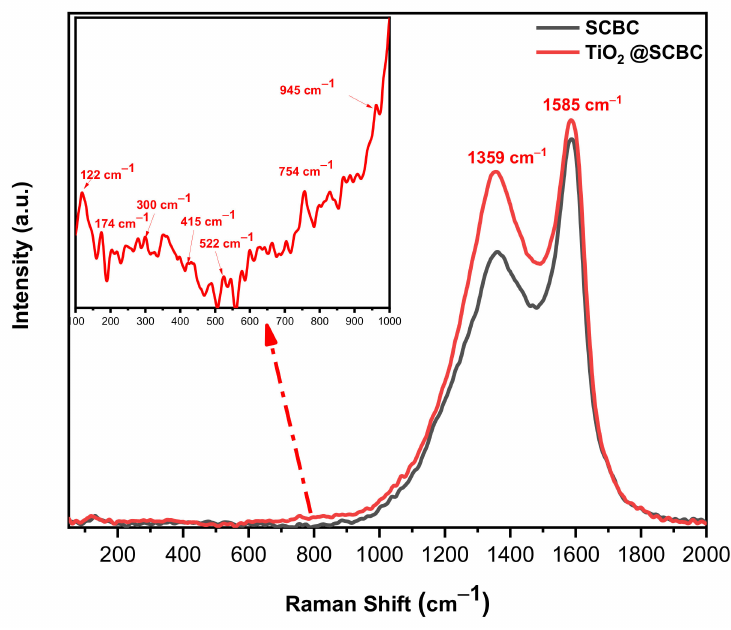
Figure 3. Raman spectra of the as-prepared adsorbents: SCBC and TiO 2